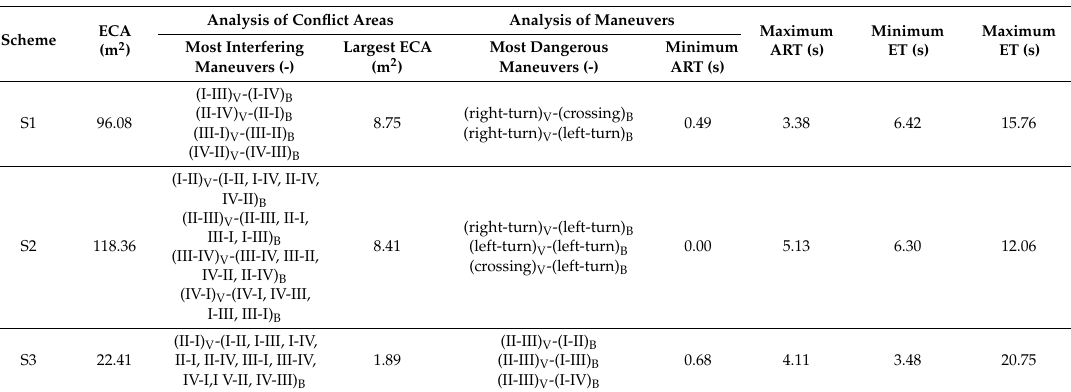
Figure 6. Conflict areas. Table 2. Analysis of the conflict areas.